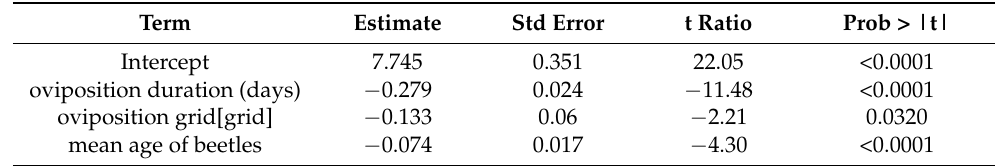
Table 7. Parameter estimates, standard error and significance level (t ratio and p -value) for linear regression model of mean hatching time (days) for experiment 2.